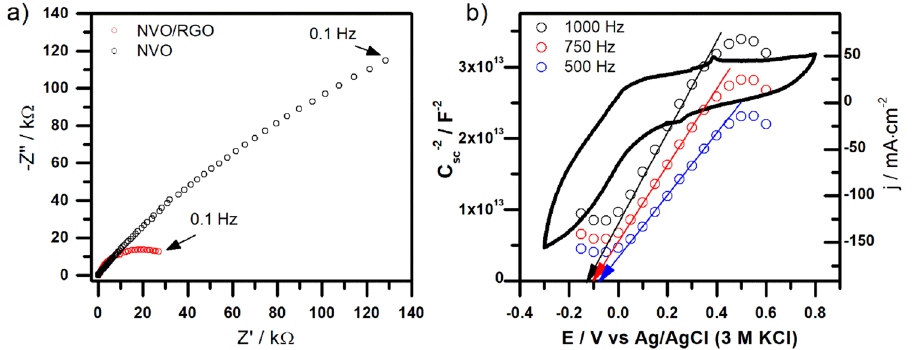
Figure 4. ( a ) Typical Nyquist plots recorded for NVO/RGO and NVO at rest potential equals to about 0.3 V and ( b ) the cyclic voltammetry curve of NVO, recorded in 0.2 M K 2 SO 4 , scan rate: 50 mV/s and Mott–Schottky plot of NVO electrode at different